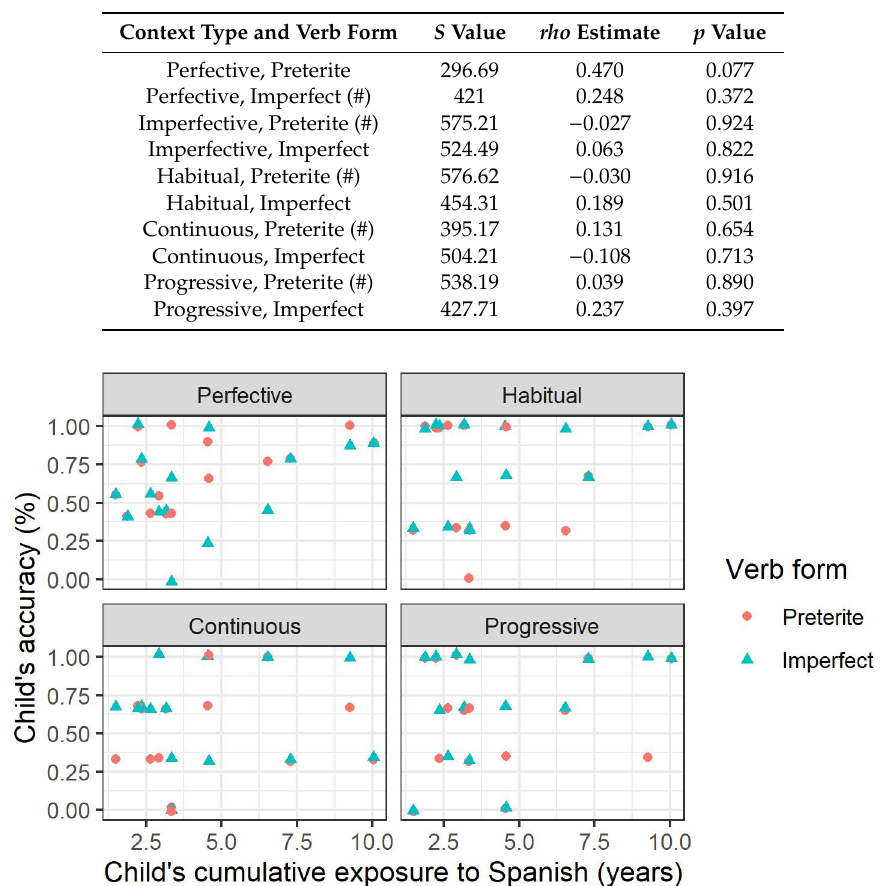
Table 6. Spearman’s rank correlations for children’s accuracy for each morpheme in each context and their cumulative exposure to Spanish.